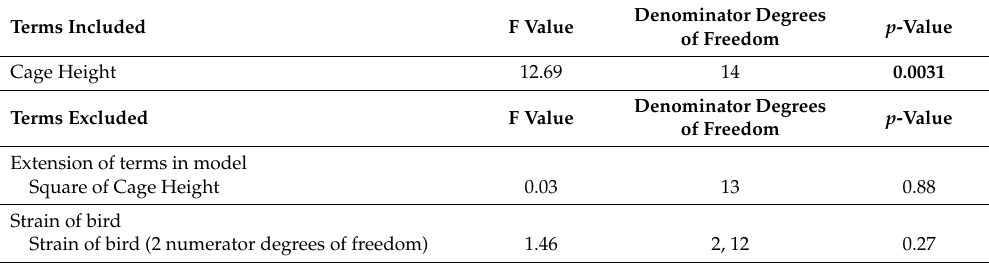
Figure 4. Relationship between average withdrawal distance in the Stroll Test and cage height. Error bars represent 95% confidence intervals.